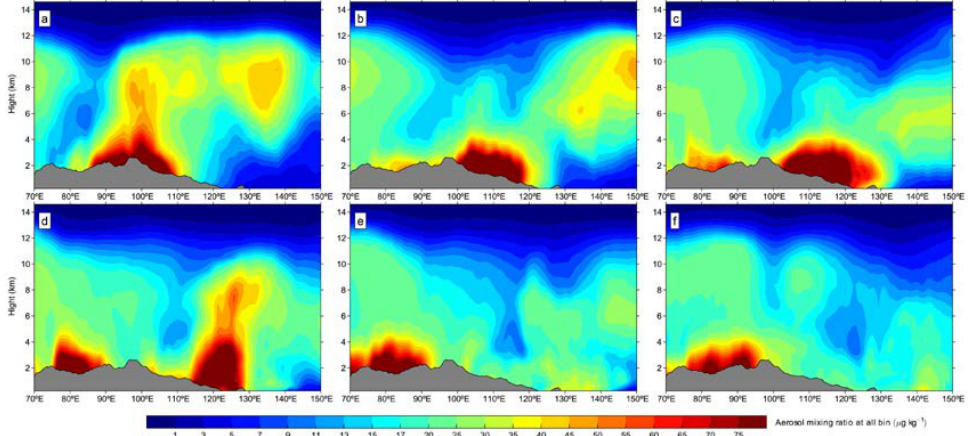
Figure 9. Vertical profile of dust aerosol mixing ratio of all bins accumulated in the atmosphere on a single day on 2–7 May 2017(sub-graph ( a – f ) respectively describe the dust aerosol mixing ratio on 2–7 May 2017).